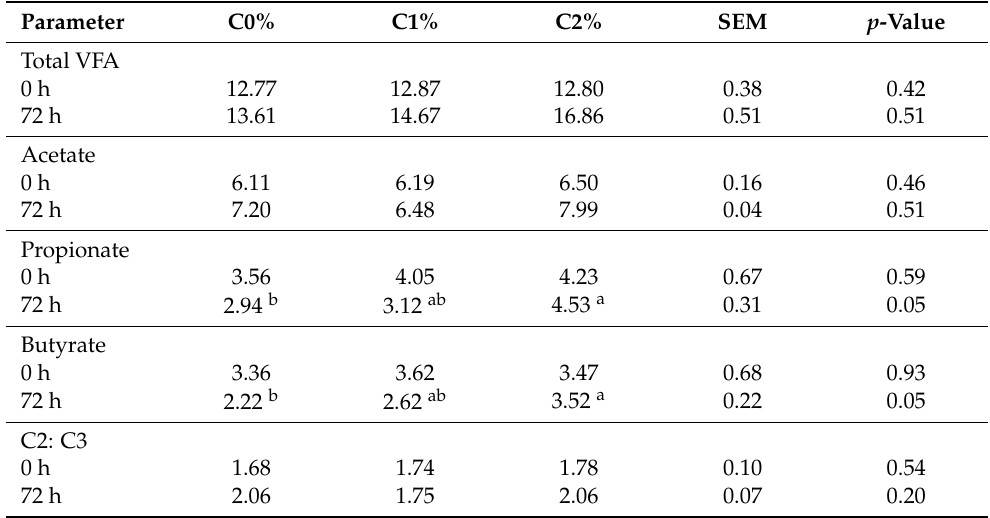
Table 5. Concentration of volatile fatty acids (VFA, mmol/ml) after 72 h in vitro fermentation of different levels of corn